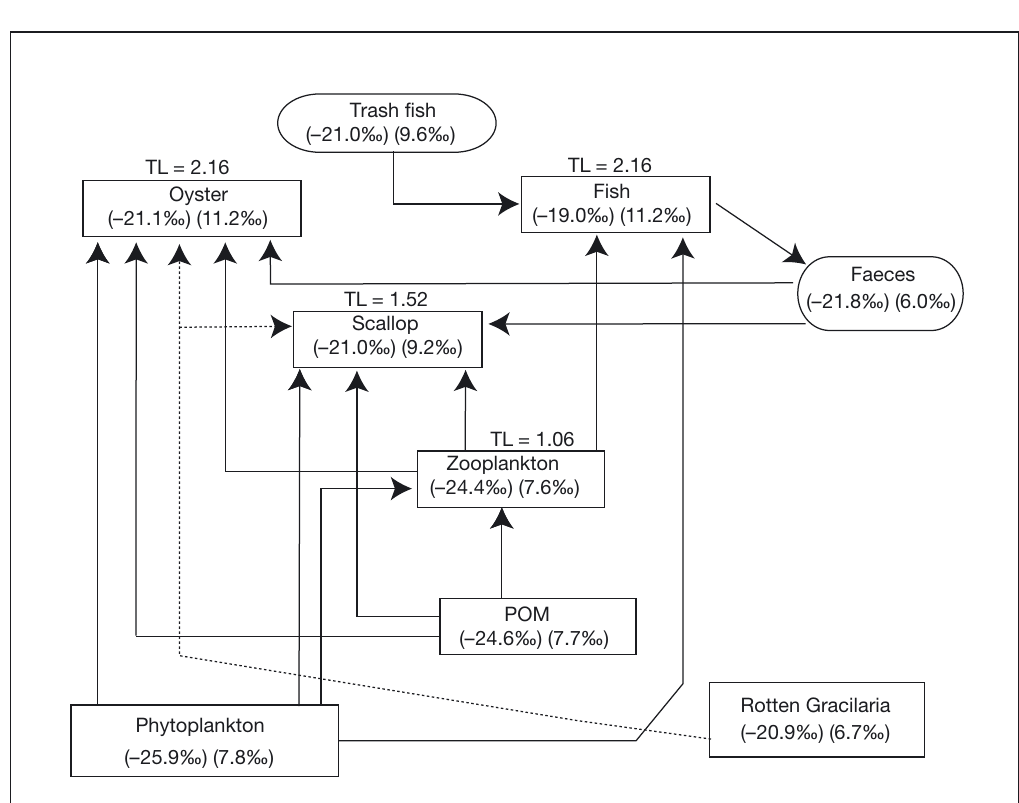
Fig. 7. Conceptual model of carbon flow among the aquaculture species in Sanggou Bay on the basis of stable isotope analysis. Values in parentheses are δ 13 C (first) and δ 15 N (second) isotopic signatures (‰) of various species and represent the flow (arrows; dotted arrows originate from rotten Gracilaria ) from one trophic level (TL) to the next, showing the trophic efficiency. The TL is given for each cultured